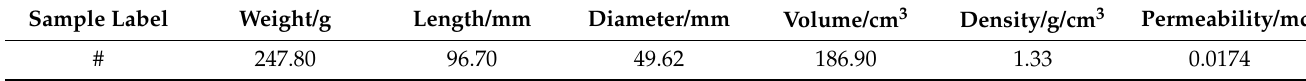
Table 2. The average value of basic data of dried raw coal sample.